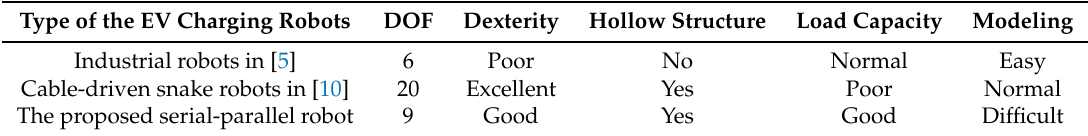
Table 1. Comparison between the electric vehicles (EV) charging robots in some literature and the proposed robot in this